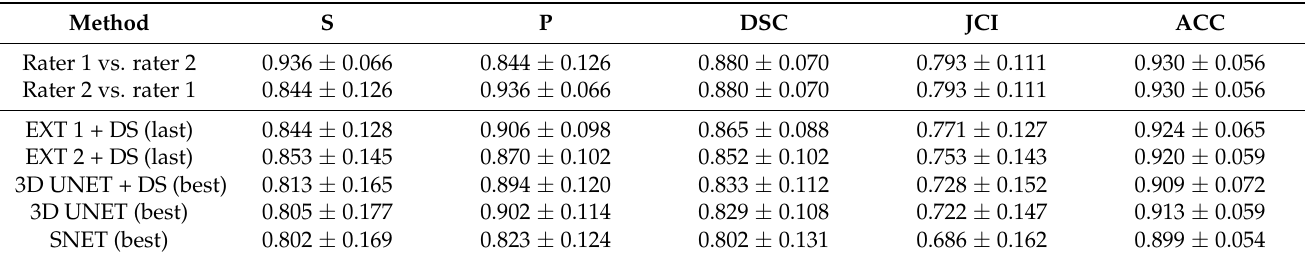
Table 8. Effectiveness of the proposed ovary detection methods compared to the state-of-the-art and inter-rater variability, calculated on ‘voxel level’. Presented are the mean and Standard Deviation of Sensitivity or Recall (S), Precision (P), Dice Similarity Coefficient (DSC), Jaccard Index (JCI), and the Accuracy (ACC) on the USOVA3D